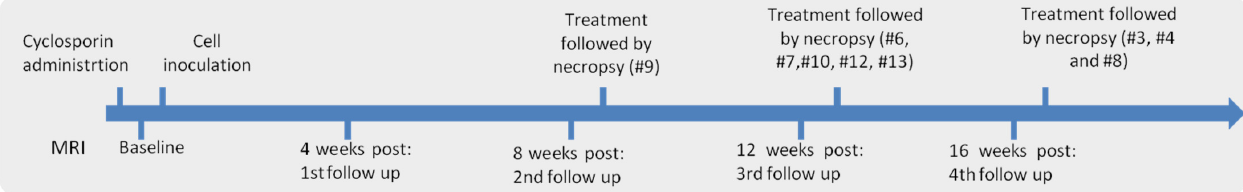
Figure 2. Timeline of the